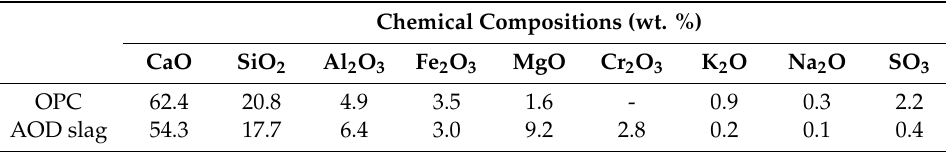
Table 1. Chemical composition of the OPC and AOD slag